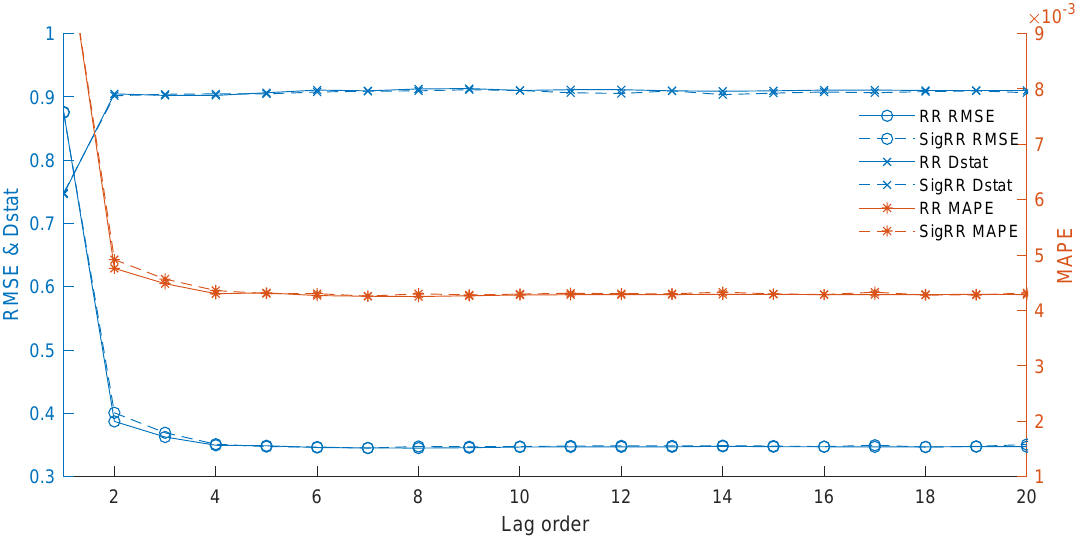
Figure 5. The impact of the lag orders by RR and SigRR.